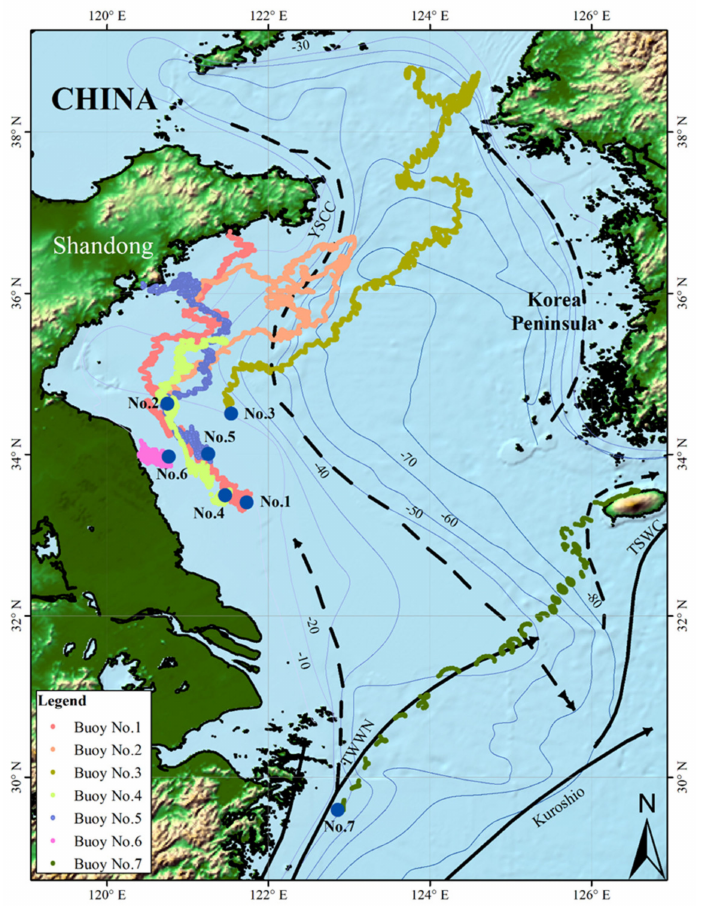
Figure 3. A trajectory map showing drifting buoys used in this study. Lines with different colors represent the tracks of the seven drifting buoys. Buoys No. 1–No. 6 collected data from June to August in 2012, while Buoy No. 7 operated in 2013. “No. 1–No. 7” are used to mark the initial releasing locations of the buoys. Bathymetry is indicated by contours from light to dark blue for the range of 10 to 80 m. The dark lines with arrowhead show the main ocean currents in the area [47]. The Zhe-min costal current is close to the coastline. There is the Yellow Sea Cold Water Mass between the Yellow Sea Costal Current (YSCC) and the Korean Peninsula Coastal Current. Table 1. Detail of drifting buoy